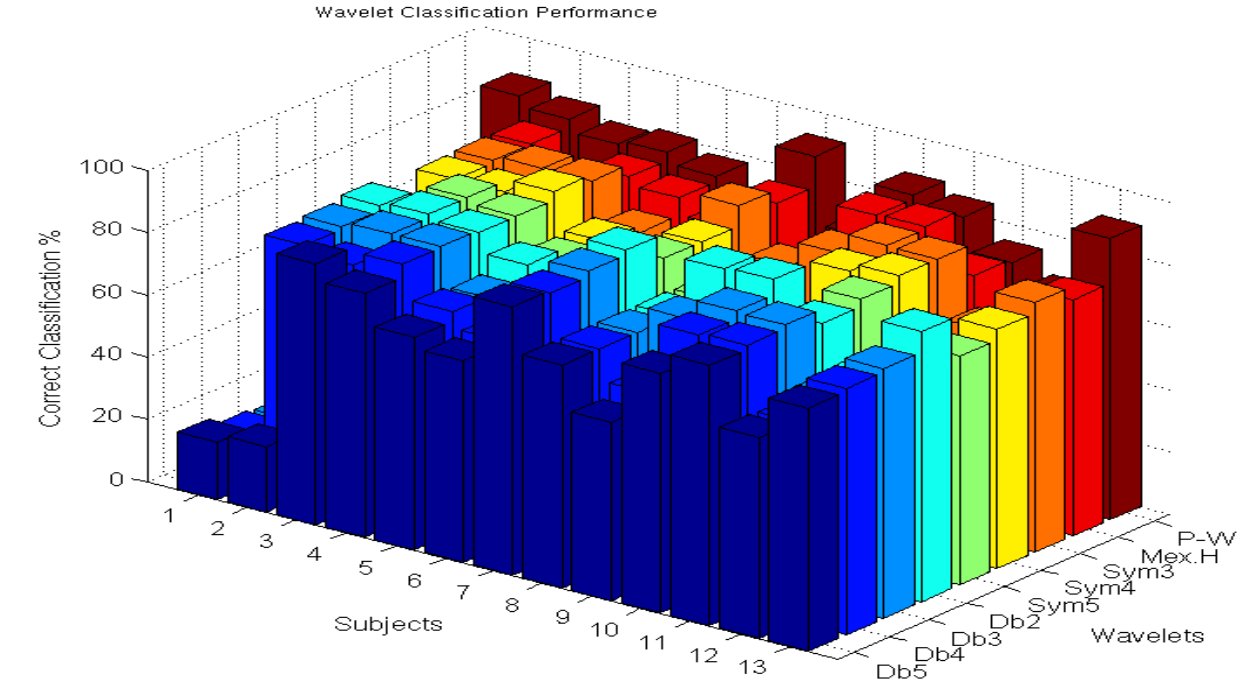
Figure 5. Graphical representation of the Classification performance (in %) (P-W =